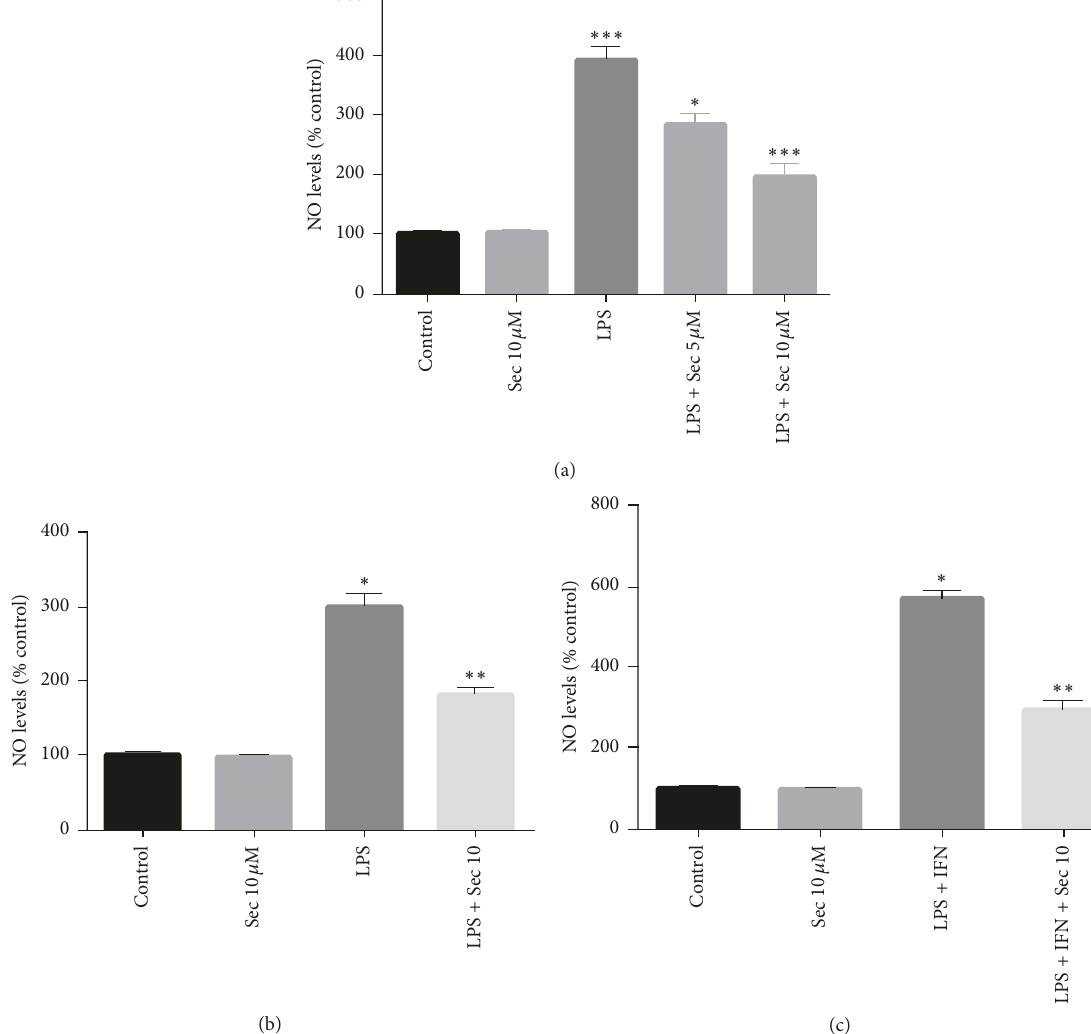
Figure 8: Securinine pretreatment inhibits LPS-induced NO production in RAW 264.7 macrophage cells and in primary astrocyte cultures. RAW 264.7 macrophage cells or primary astrocyte cultures (10 × 10 4 cells/well in 48-well plates) were incubated with 500 ng/mL of LPS or LPS/IFN- 𝛾 (50 unit/mL) in the presence or absence of securinine (10 𝜇 M) for 24 h. The amount of nitrite secreted into the supernatant was measured using the Griess Reagent assay ((a) RAW 264.7 cells, ∗∗∗ 𝑃 < 0.05 versus control; (b and c) primary astrocyte cultures). The data were expressed as the mean ± SD ( 𝑛 = 3 ) and are representative of three independent experiments. ∗ 𝑃 < 0.05 and ∗∗ 𝑃 < 0.01 , significantly different from cells treated with LPS